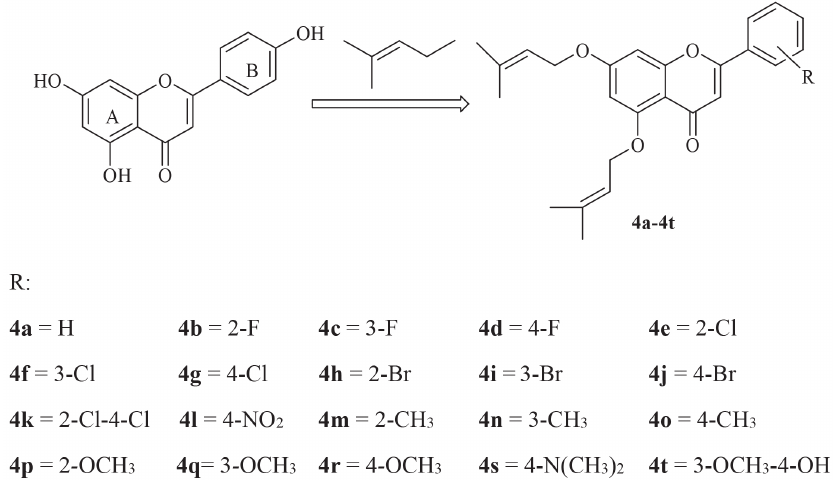
FIGURE 1 - The structure of apigenin and general structure of compounds